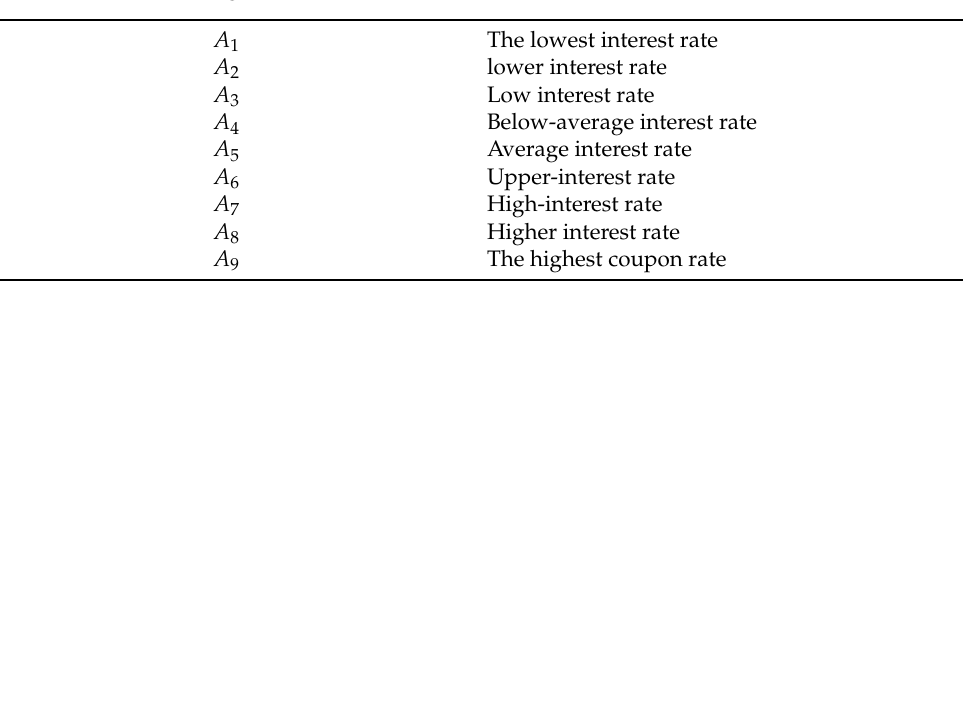
Table 19. Interest rate linguistic